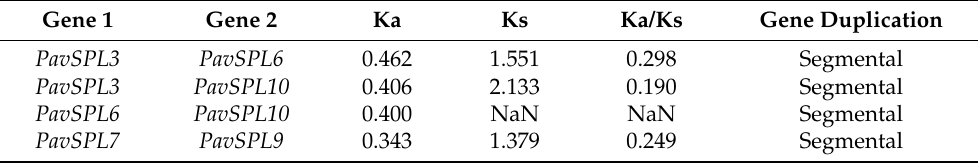
Table 2. Calculation of Ka and Ks ratios of duplicated PavSPL gene pairs.